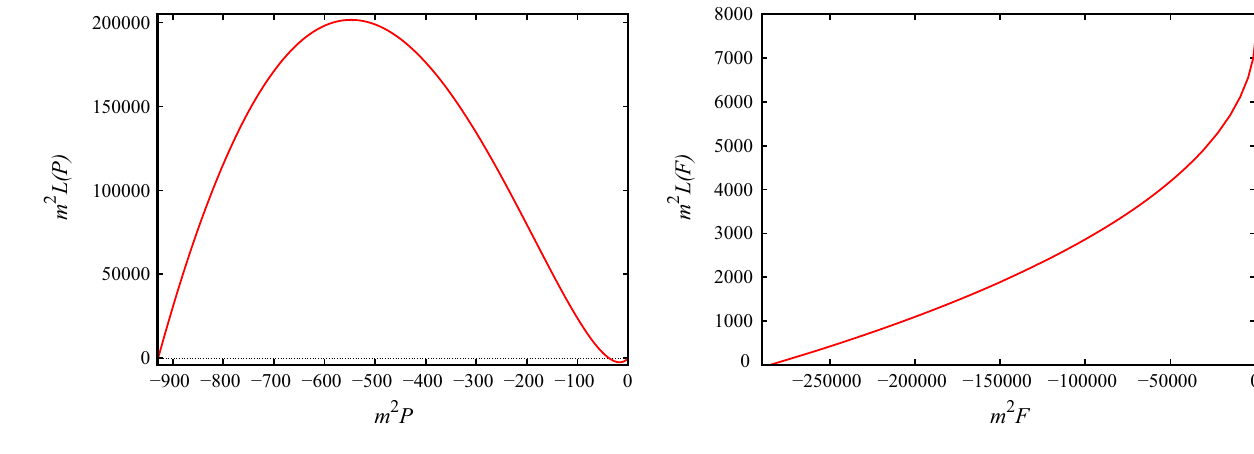
Fig. 2 Behavior of L ( F ) × F and L ( P ) × P for c 0 = 1, mc 1 = 1, m 2 (cid:12) = 0 . 02 and q = 0 . 4